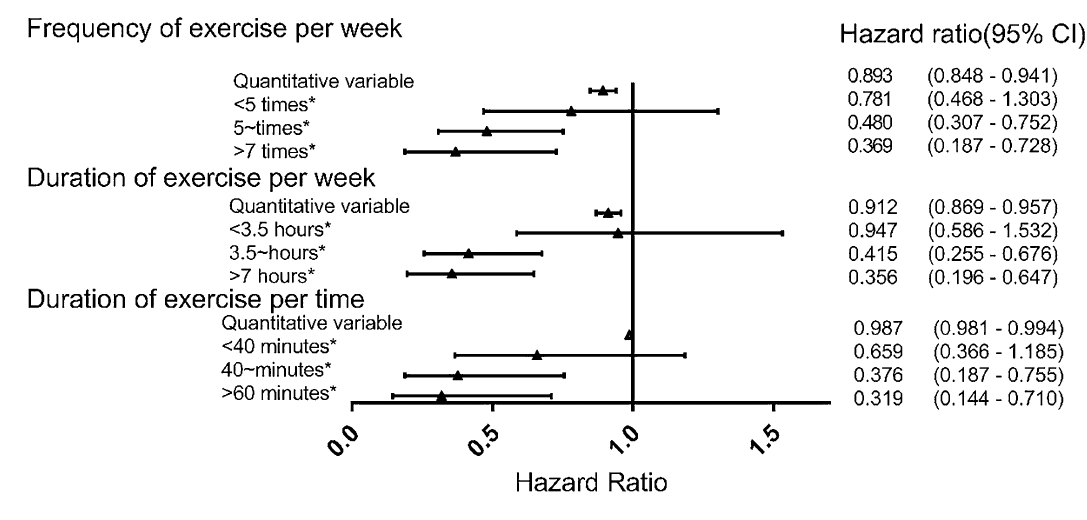
Figure 4. The effect of exercise on stroke